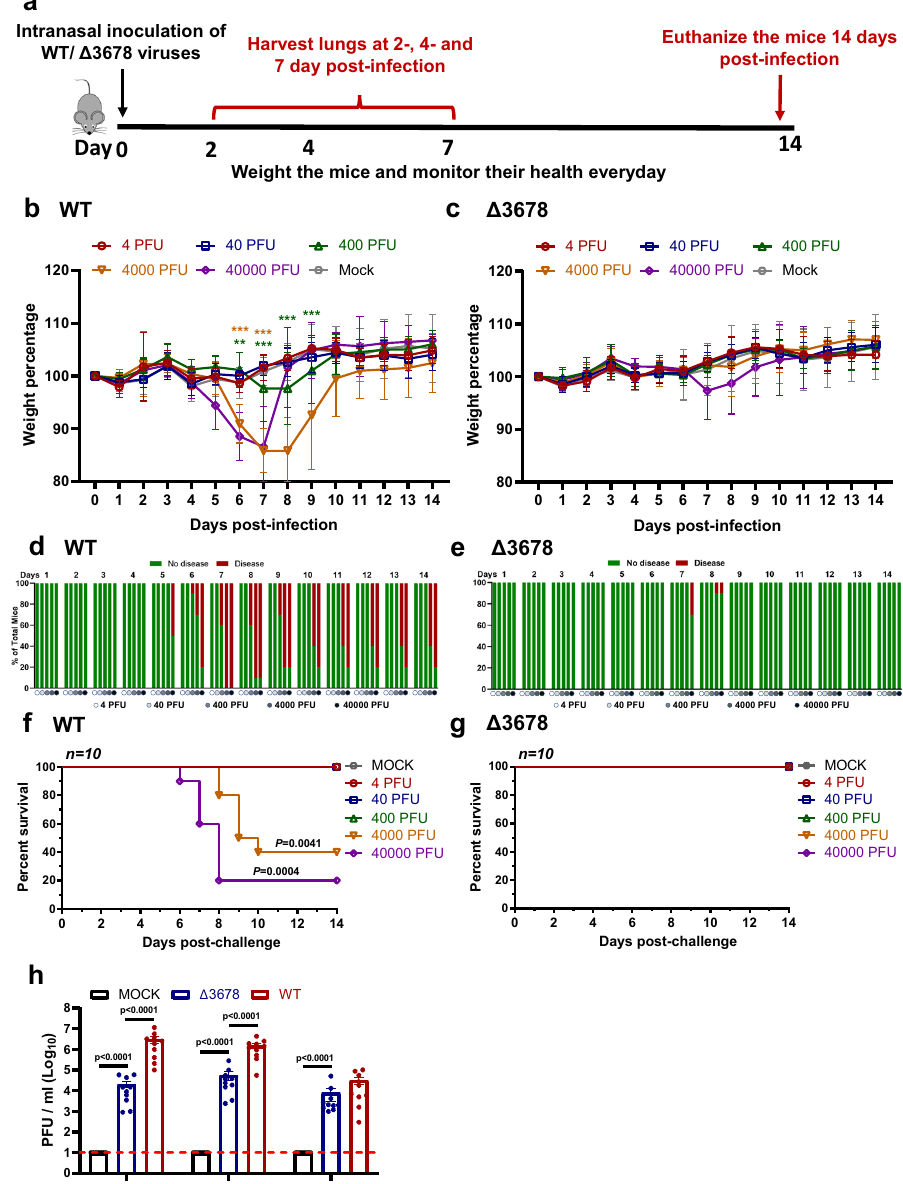
Fig. 4 | Attenuation of Δ 3678 SARS-CoV-2 in K18-hACE2 mice. a Experimental scheme. K18-hACE2 mice were intranasally inoculated with 4, 40, 400, 4000, or 40000 PFU of WT ( n =10) or Δ 3678 virus ( n =10). Lung viral loads were measured on days 2, 4, and 7 post-infection. The infected mice were monitored for body- weight( b , c ),disease( d , e ),andsurvivals( f , g )for14days. b , c